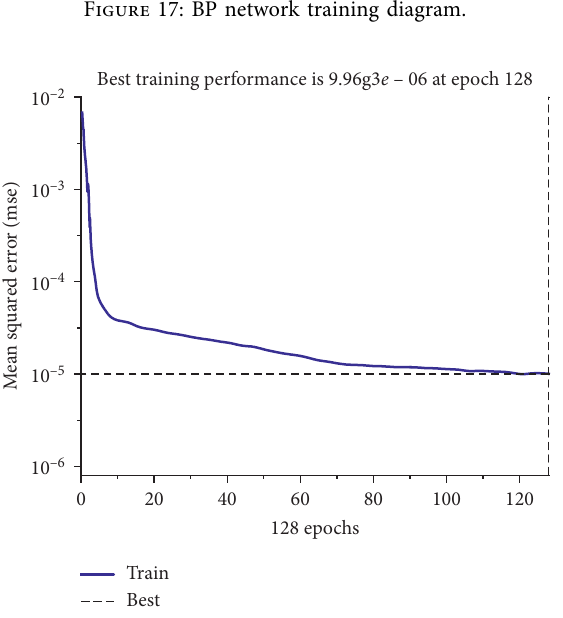
Figure 17: BP network training diagram.